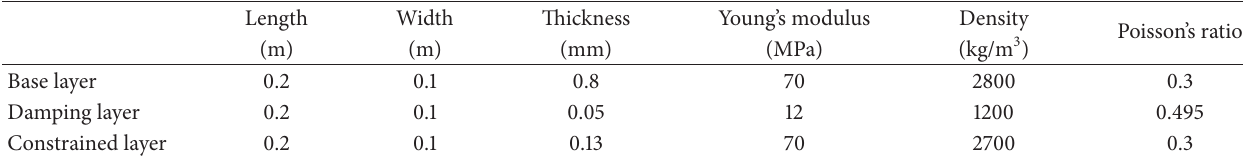
Table 1: Physical and geometrical parameters of CLD plate.